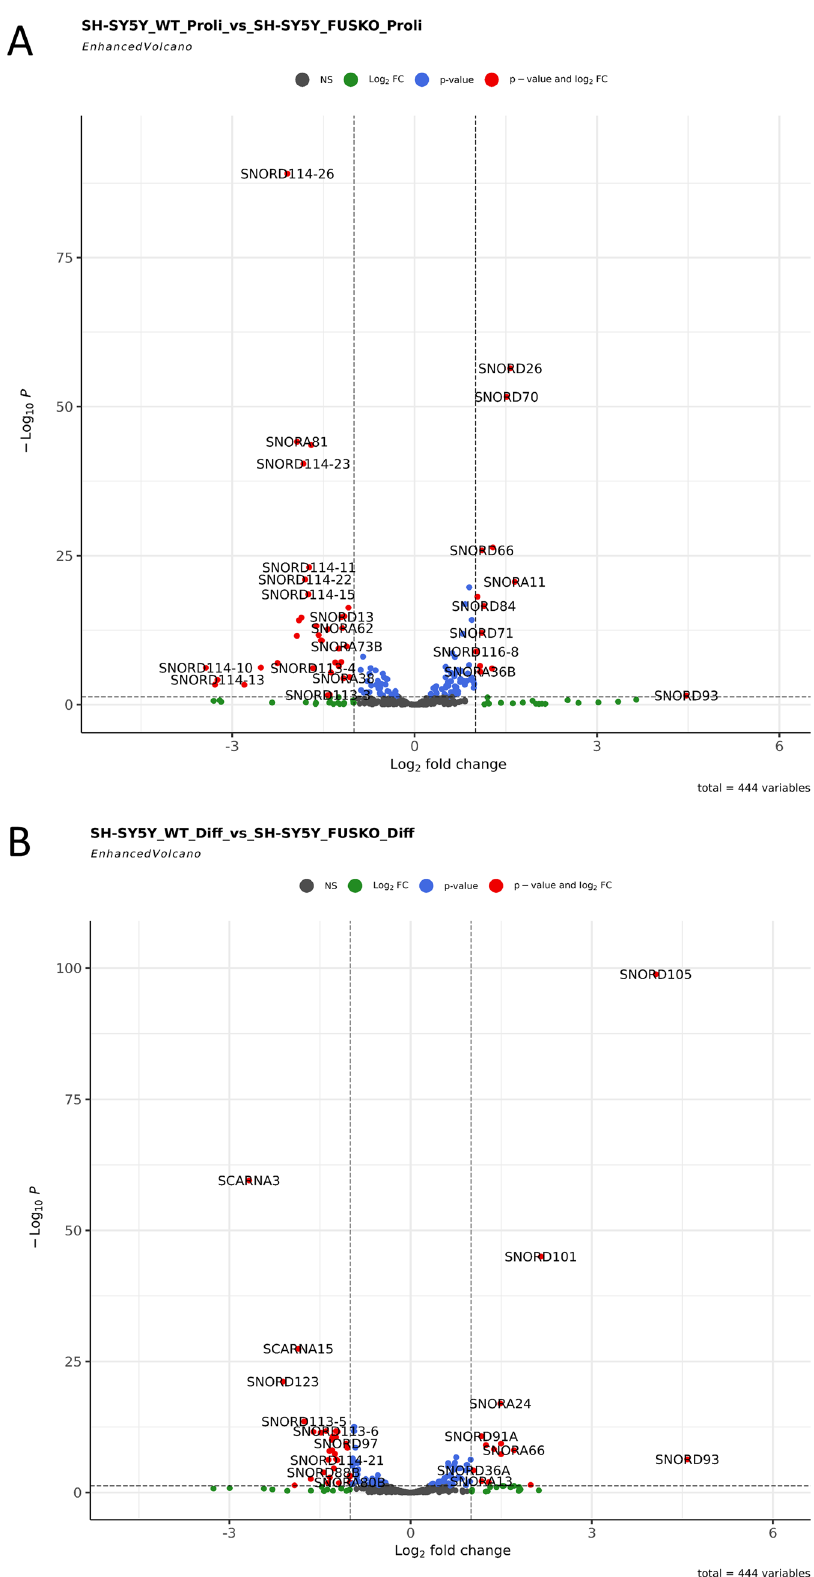
Figure 1. Volcano plots for proliferating ( A ) and differentiated ( B ) SH-SY5Y cells. Enhanced Volcano plots were generated using Enhanced Volcano R package. Raw count matrix with only snoRNAs was used in DESeq2 to get differentially expressed snoRNAs (padj ≤ 0.05), the tabular file generated was then used in Enhanced Volcano library with x-axis = ’log2FoldChange’ and y-axis = ’padj’. Representative differentially expressed snoRNAs are annotated. (NS: